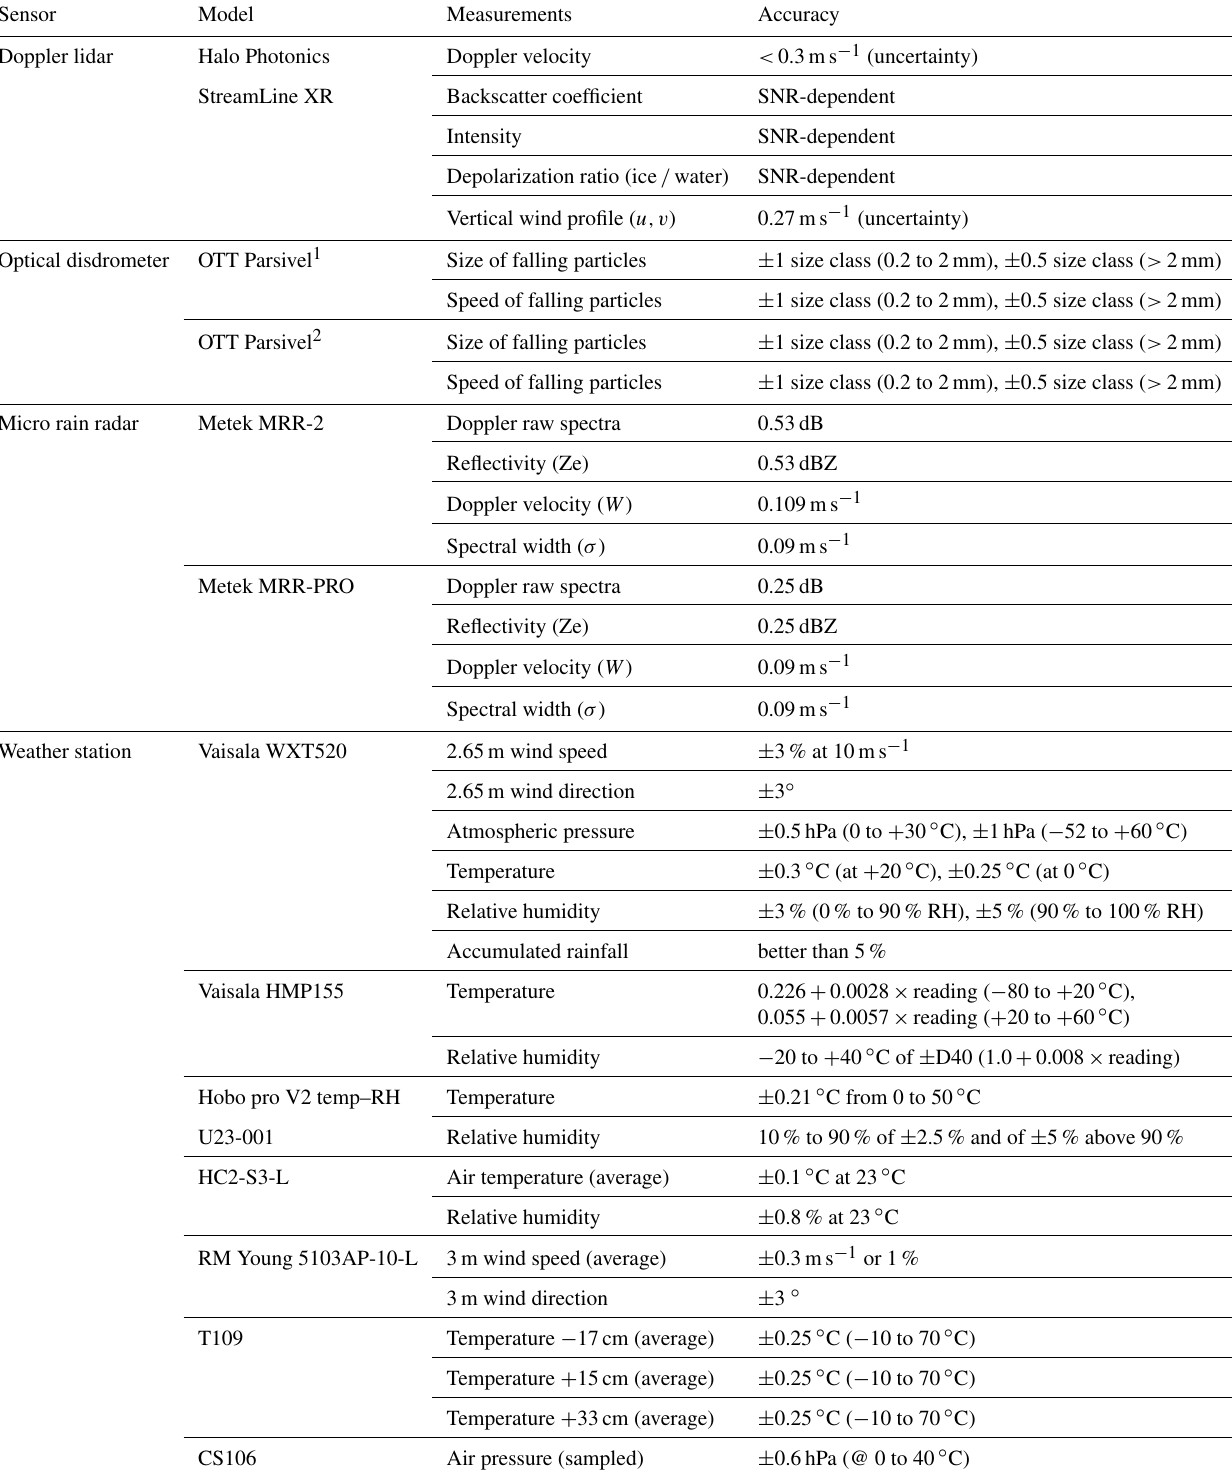
Table A2. Summary of the instruments’ accuracy found in the user’s manual of each instrument. For all instruments except the lidar, only the variables found in the user’s manual are listed. For the lidar the information is from the user’s manual as well as from Mariani et al.